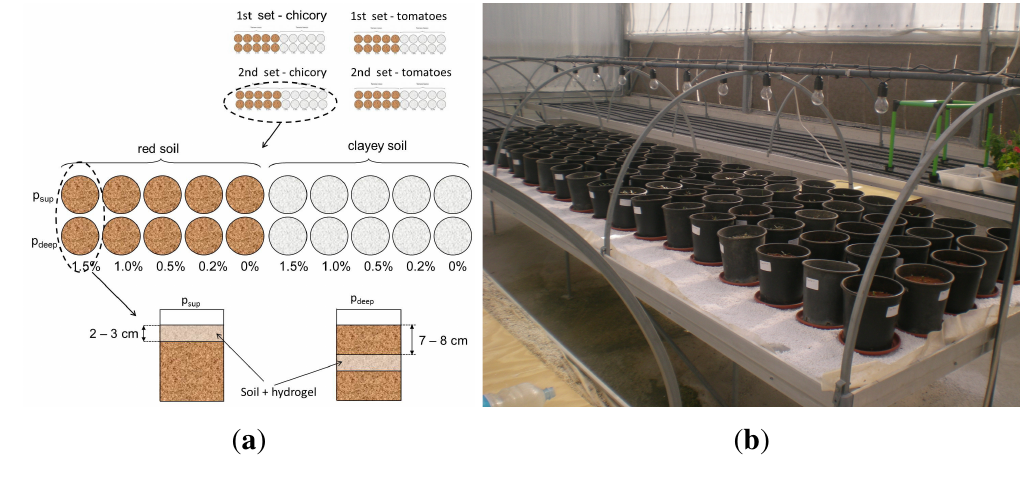
Figure 1. Schematization of the 80 pots that were prepared. The figure also indicates the different weight percentage of Superabsorbent polymer (SAP) and the portion of soil that was mixed with the SAP ( a ); Picture of the plant pots as prepared for the experiment ( b ).